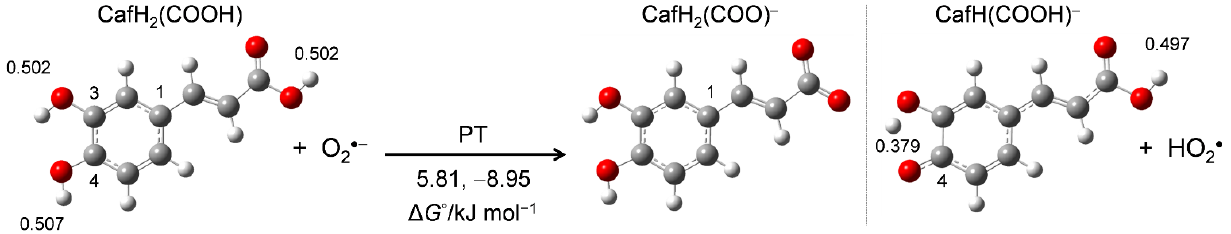
Figure 4. Optimized structures of CafH 2 (COOH) and its deprotonated anion conformers (CafH 2 (COO) − and CafH(COOH) − ) along the PT route to O 2• − in DMF, calculated by DFT-